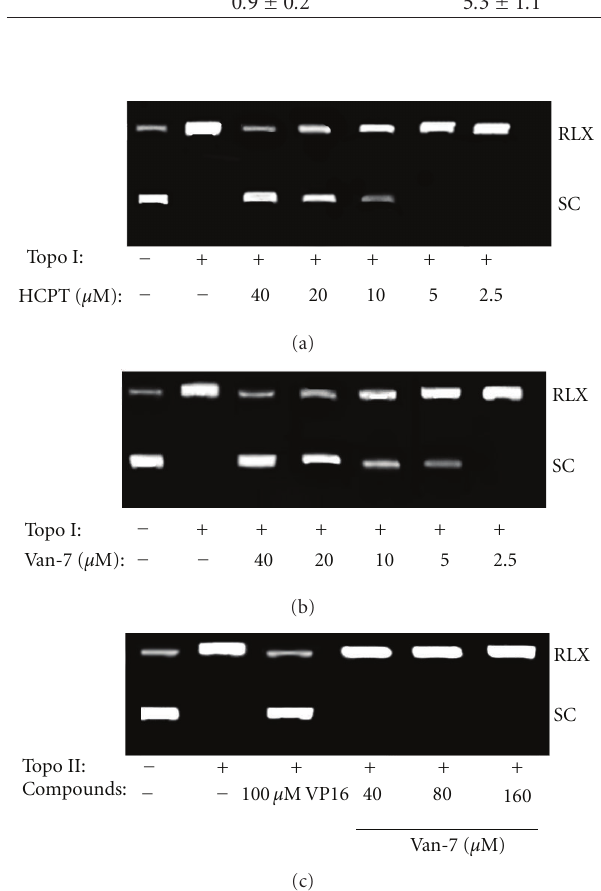
Figure 2: (a) E ff ect of HCPT on Topo I-mediated supercoiled pBR322 relaxation. (b) E ff ect of Van-7 on Topo I-mediated super- coiled pBR322 relaxation. Both of the two reactions were carried out without ATP. (c) E ff ect of Van-7 on Topo II-mediated supercoiled pBR322 relaxation. The reaction was carried out in presence of ATP. RLX: relaxed DNA, a circular DNA molecule that has no superhelical turns. SC: supercoiled DNA,over- or underwinding of a DNA